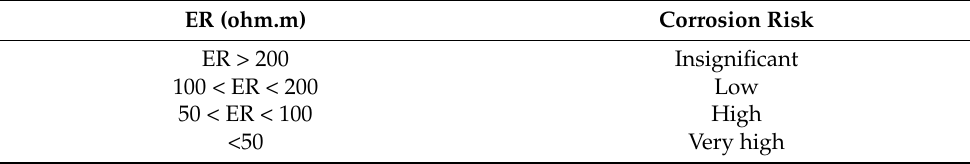
Figure 14. Summary of electrical resistivity (ER) results: ( a ) Tukey’s test for the samples without polypropylene fibers, ( b ) Tukey’s test for the samples with polypropylene fibers, ( c ) Tukey’s test for the samples without and with polypropylene fibers and ( d ) Quadratic regression model fit to the experimental data set considering only the effect of temperature as an independent factor. The uppercase letters A–E in figure mean equivalence between the sample results. Table 2. Corrosion risk as a function of concrete surface electrical resistivity [62]. ER